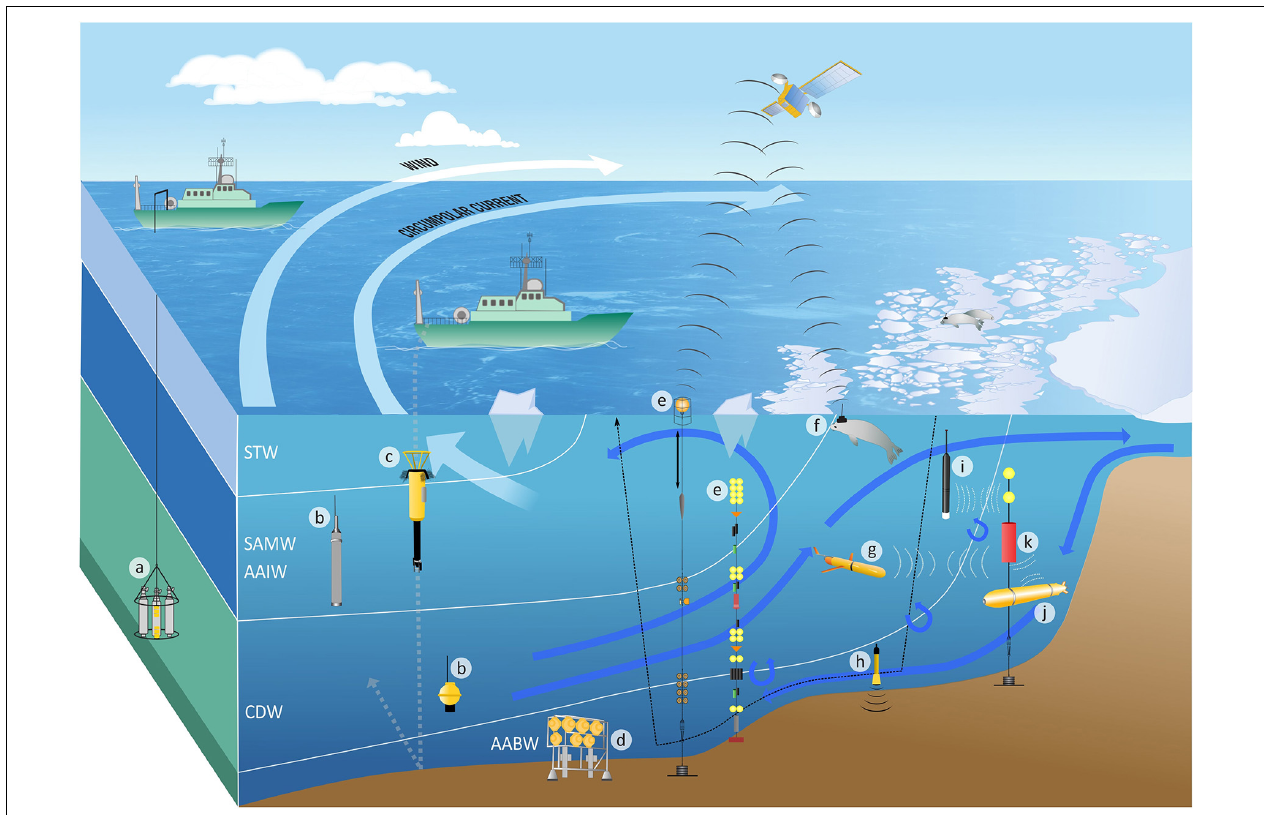
FIGURE 5 | A schematic of the observational platforms required to observe the AABW formation. (a) Conductivity–temperature–depth profiler often equipped with additional sensors such as dissolved oxygen, horizontal velocity (lowered ADCP – yellow cylinders), and temperature turbulence; (b) Argo profiler, both on core mission (depth < 2000 m) and deep mission (deeper); (c) microstructure profiler measuring energy and material dissipation rate; (d) bottom lander with a suite of instruments including water sample; (e) mooring system with physical (temperature, salinity, velocity) and biogeochemical (sediment trap, etc.) measurements, some with an underwater winch-driven surface buoy for ice avoidance; (f) animal tagged profiler; (g) glider; (h) bottom drifter, a float specially targeting AABW; (i) under-ice Argo profiler with acoustic locating capability; (j) autonomous underwater vehicle; and (k) a sound source for acoustic float locating. Modified from Meredith et al.